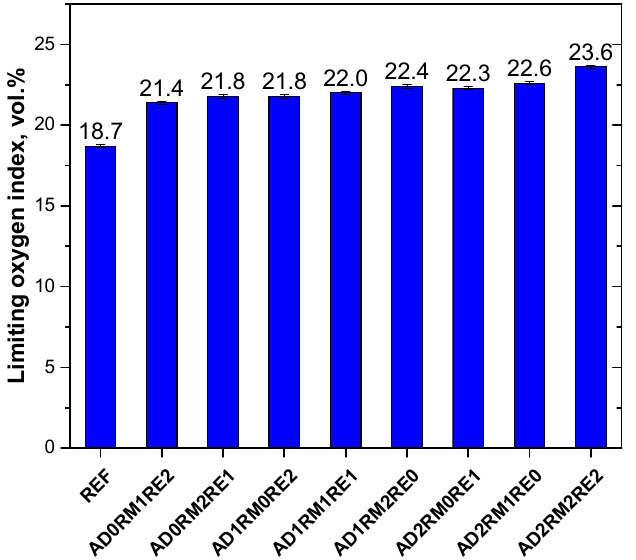
Figure 6. Limiting oxygen index of obtained rigid polyurethane foams.